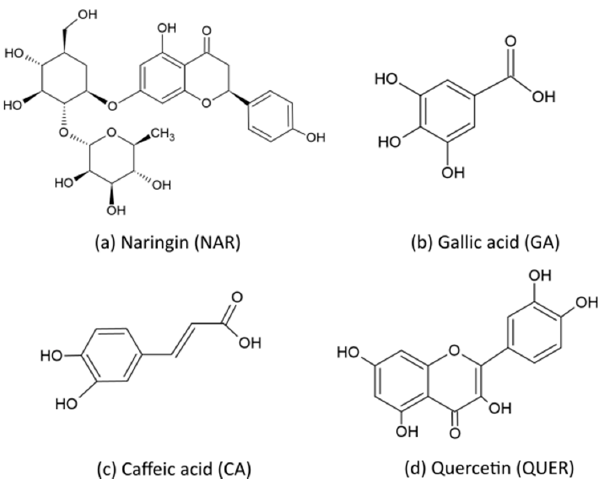
Figure 1. Chemical structure of ( a ) Naringin (NAR); ( b ) Gallic acid (GA); ( c ) Caffeic acid (CA); and ( d ) Quercetin (QUER).